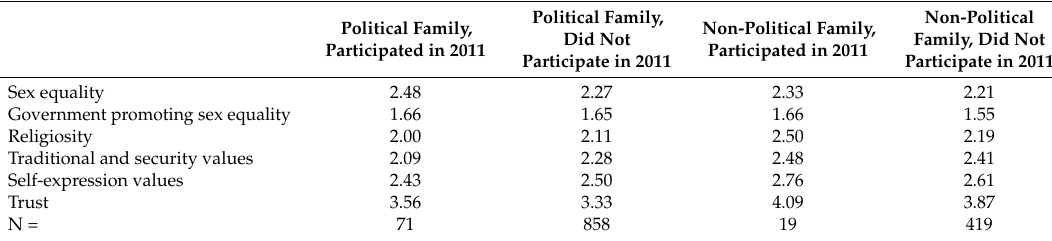
Table 4. Political orientations: mean scores, 20–29 year olds. Political Family, Participated in 2011